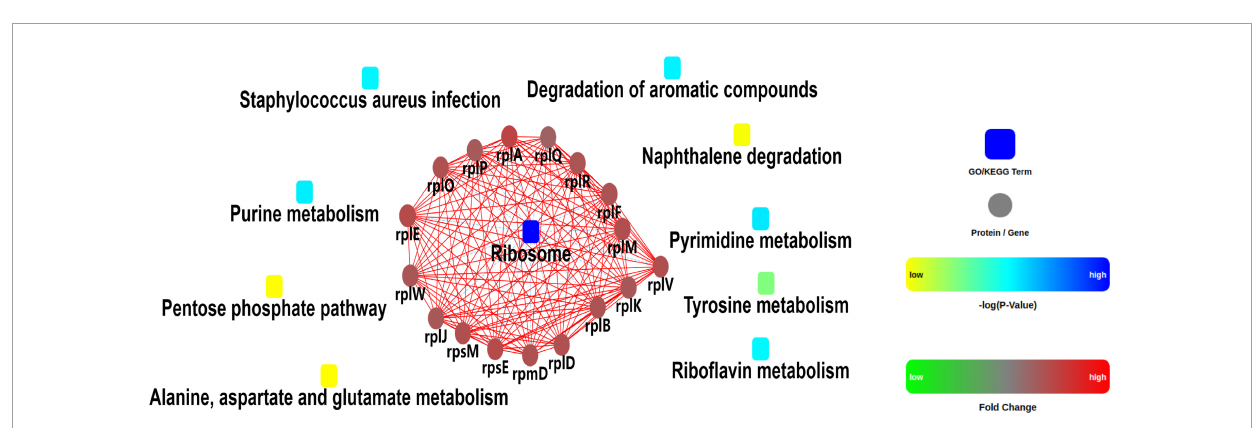
FIGURE6 Protein–protein interaction network analysis for the differentially expressed proteins between the control groups and radezolid-treated groups.